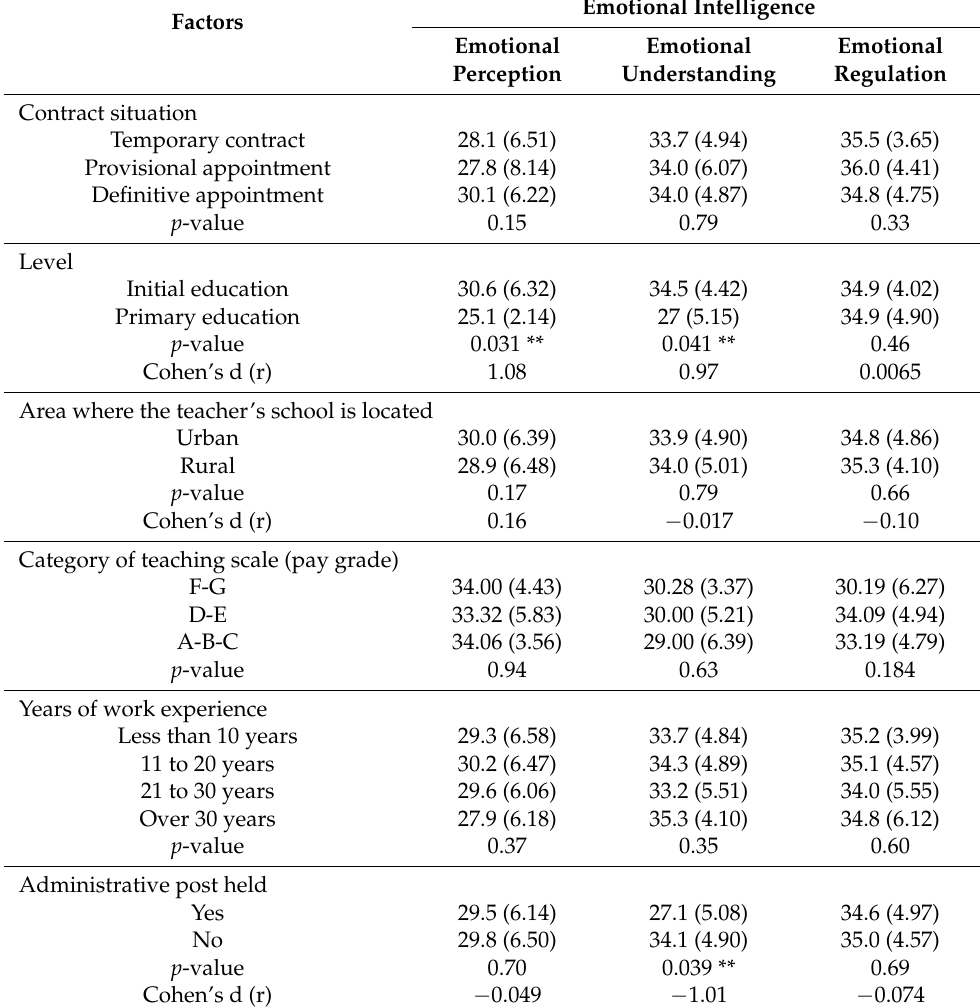
Emotional Intelligence Emotional Emotional Emotional Perception Understanding Regulation